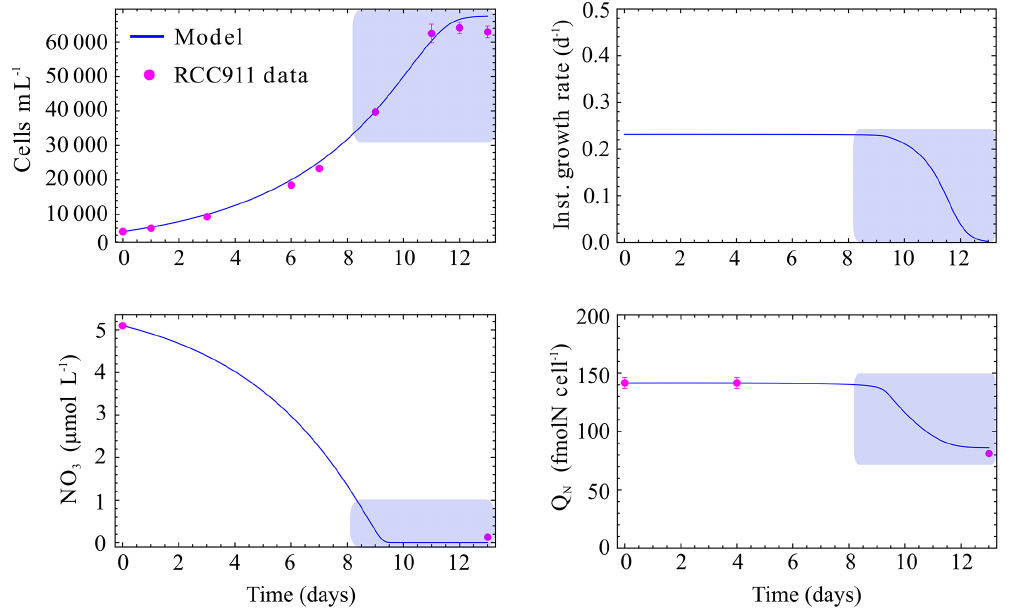
Figure 8. Model fitted to the data of the nitrate-limited cultures on RCC911 strain in low light. The shaded area corresponds to the equivalent nitrate concentration in the BIOSOPE ecological niche of coccolithophores at the GYR station (between 150 and 200m